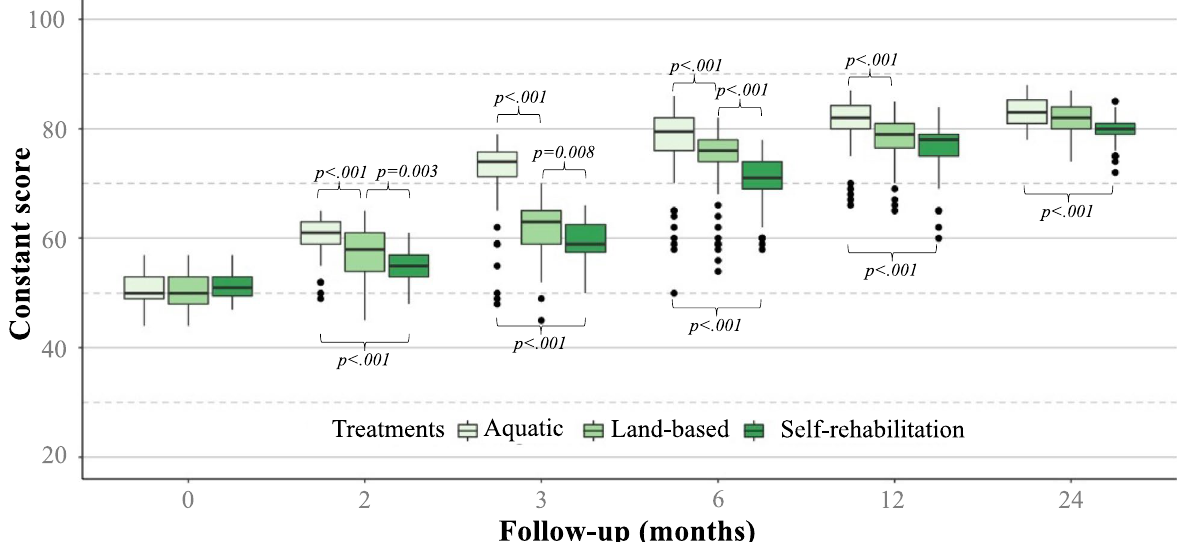
Fig. 2 Constant score for aquatic therapy, land-based therapy, and self-rehabilitation therapy for 24 months following rotator cuff